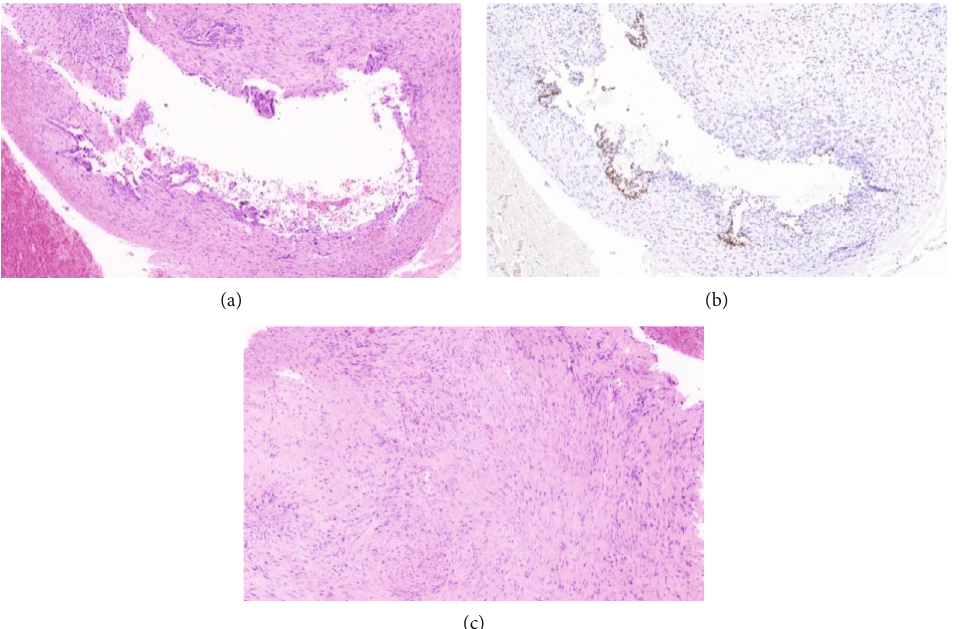
Figure 3: Histopathology. (a) Endometrioid epithelium showing reactive-type changes. (b) Estrogen receptor immunohistochemistry positivity in the endometrioid epithelium. (c) Stromal component showing fi